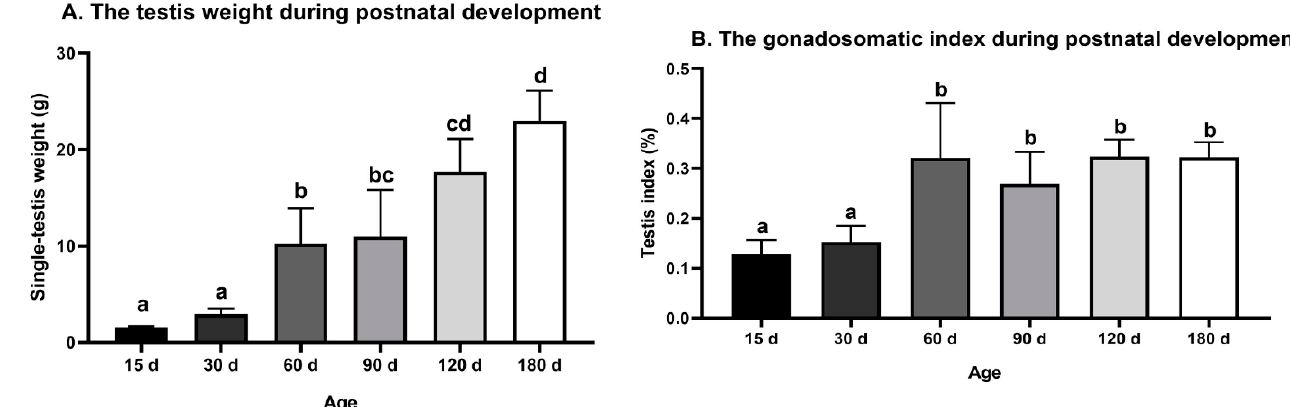
Figure 1. Testis weight and gonadosomatic index during postnatal development of the Congjiang Xiang pig. ( A ) The testis weight of Congjiang Xiang pigs from 15 day to 180 day. ( B ) The gonadosomatic index of Congjiang Xiang pigs from 15 day to 180 day was calculated by dividing testis weight by body weight. Measurements are means of left and right testes of a pair. All results are indicated by means ± SD ( n ≥ 3). The data was analyzed by one-way ANOVA with Tukey’s multiple comparisons. Values not sharing the same letter (a–d) denote significant differences among groups ( p < 0.05).